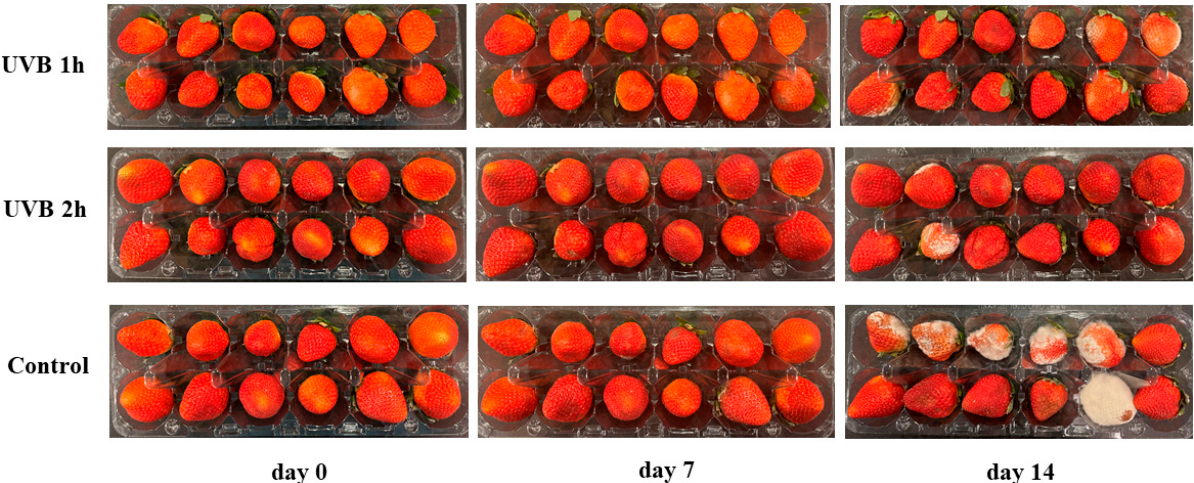
Figure 1. Effect of preharvest UV-B treatment on fruit appearance and shelf life. Red fruits were harvested from plants treated with different durations of UV-B (0.7362 J/s m 2 ) treatment and control (no treatment). Fruits were stored at 5 °C and 75% relative humidity. Photos were taken on day 0 (harvest day) and days 7 and 14 after harvest.